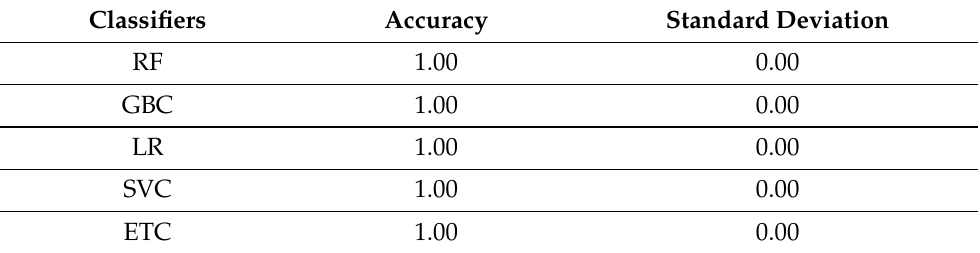
Table 8. 10-fold cross-validation results of RF and GBM features using machine learning